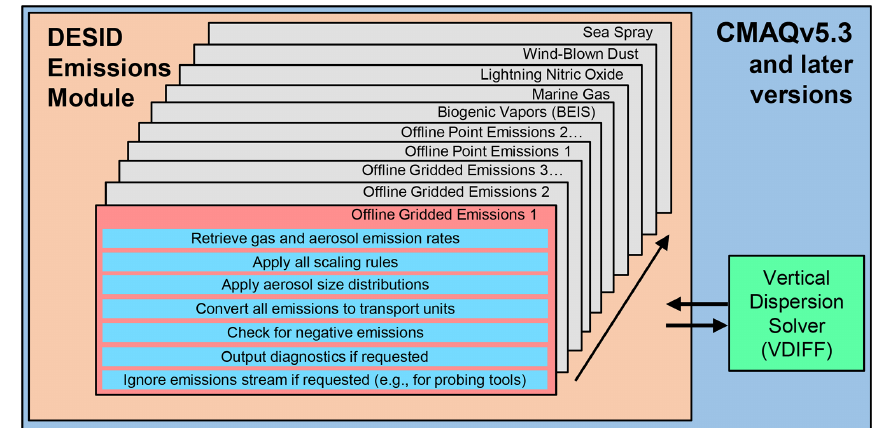
Figure 3. Algorithm for emission stream processing used by DESID. Emission rates are processed for each emission stream independently before DESID proceeds to the next stream.